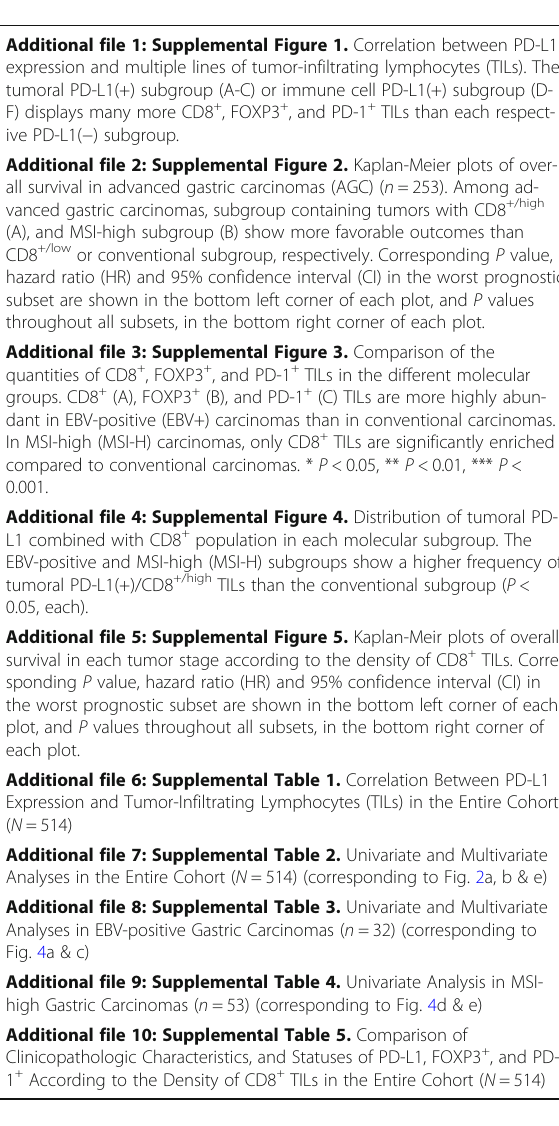
Additional file 1: Supplemental Figure 1. Correlation between PD-L1 expression and multiple lines of tumor-infiltrating lymphocytes (TILs). The tumoral PD-L1(+) subgroup (A-C) or immune cell PD-L1(+) subgroup (D- F) displays many more CD8 + , FOXP3 + , and PD-1 + TILs than each respect- ive PD-L1( − ) subgroup. Additional file 2: Supplemental Figure 2. Kaplan-Meier plots of over- all survival in advanced gastric carcinomas (AGC) ( n = 253). Among